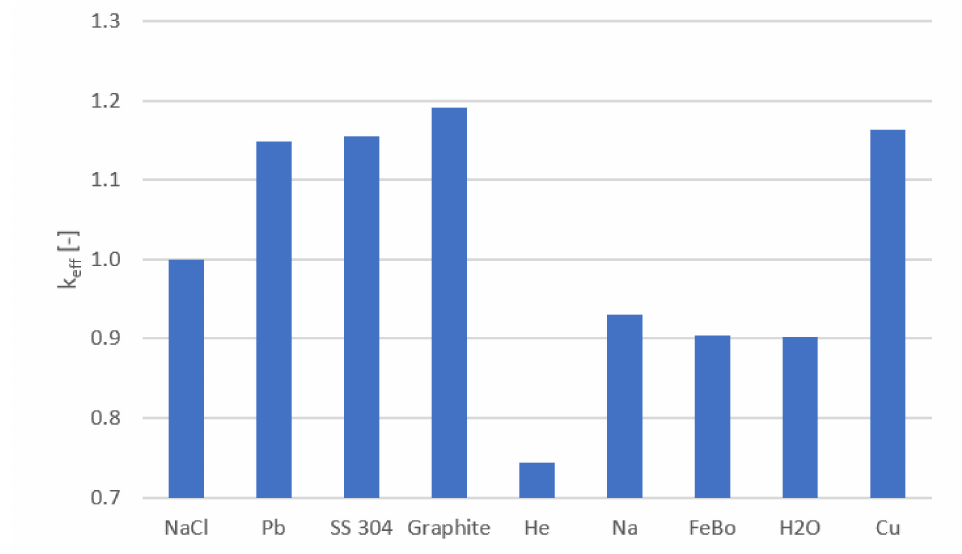
Figure 4. Analysis of the effect of a 30 cm thick reflector made from different materials used in nuclear reactors and experiments on the criticality of the studied 2D test core.